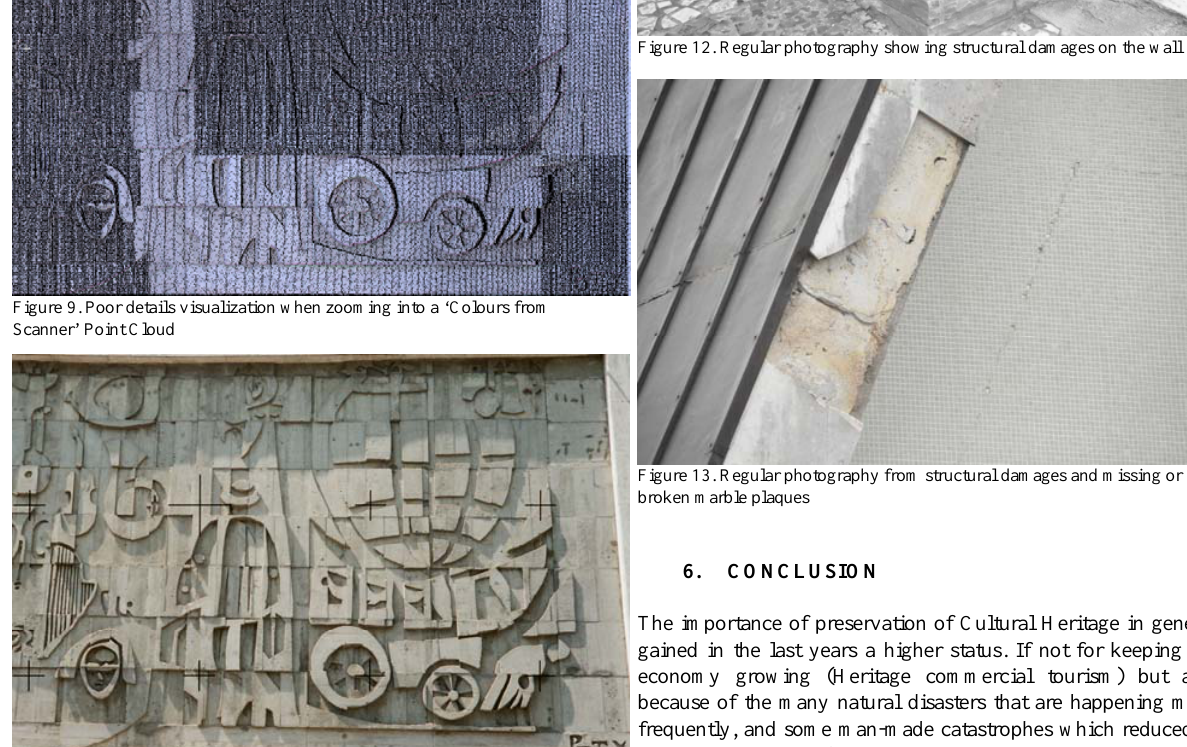
Figure 12. Regular photography showing structural damages on the wall